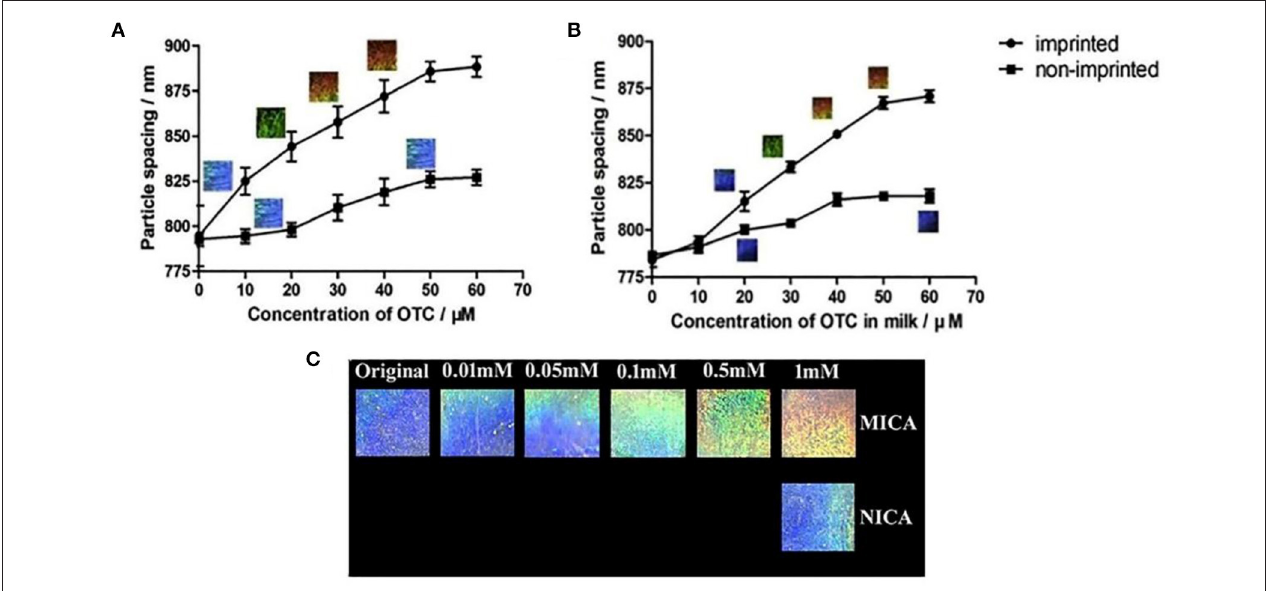
FIGURE 2 | The analysis of oxytetracycline (OTC) by OTC-imprinted hydrogels and non-imprinted hydrogels in (A) aqueous solution and (B) milk, respectively (reprinted with the permission of Wang et al., 2019a; copyright 2019 Elsevier); (C) the structure color change of molecularly imprinted colloidal array and non-imprinted colloidal array (NICA) in clindamycin hydrochloride solution (reprinted with the permission of Wang et al., 2019b; copyright 2019 Royal Society of